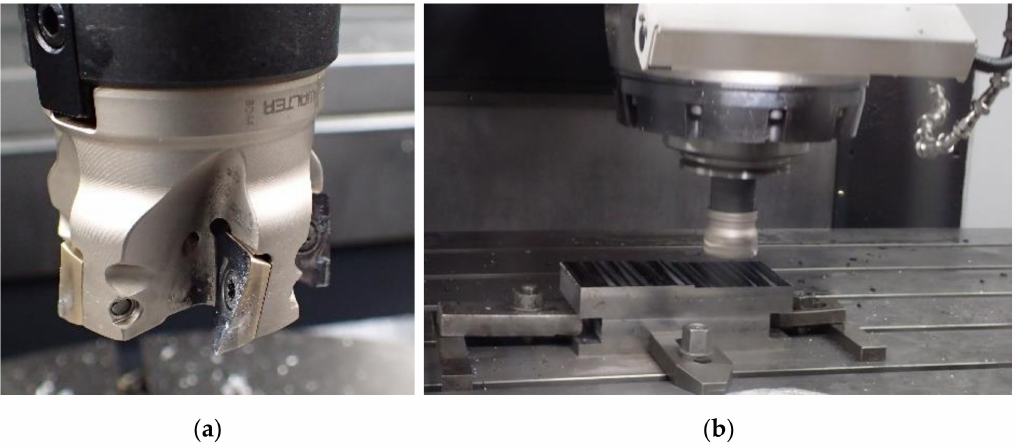
Figure 7. The cutting tool used for the machine-to-machine validation: ( a ) ADMT 160608R-F56 milling head with ADMT 160608R-F56 insert; ( b ) machining setup on the MCV 2220 machine tool.